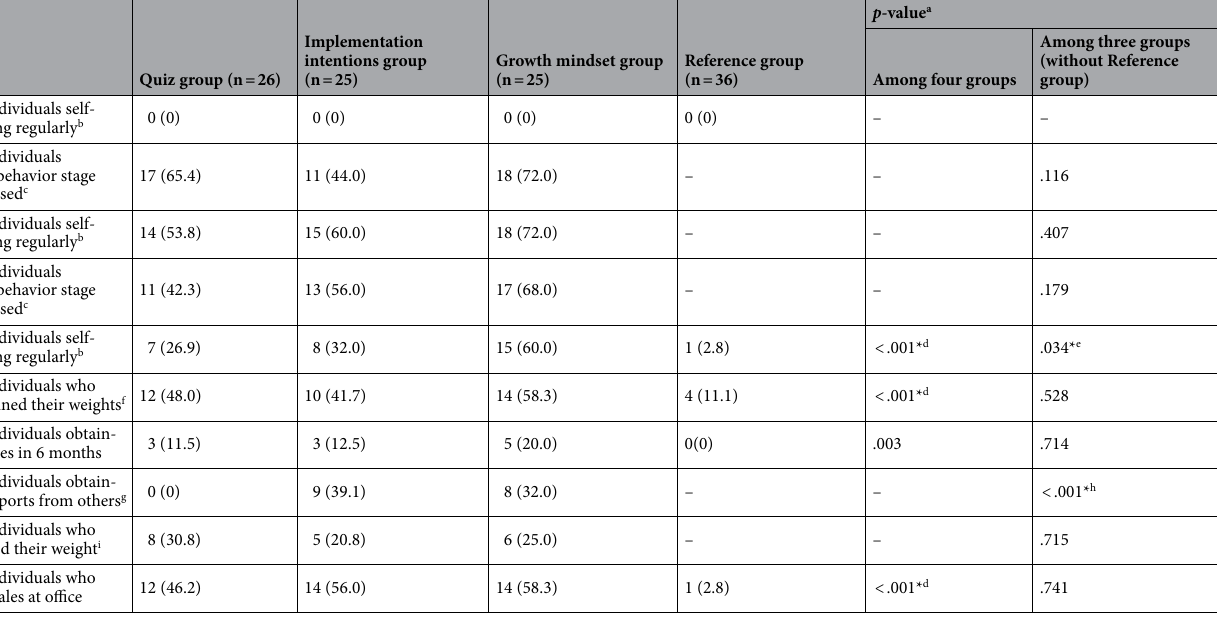
Table 2. Comparison of outcomes [n (%)]. Analysis excluding missing values, analysis of variance for continuous value data, χ 2 test, or Fisher’s exact test (items less than 5). [T0] immediately before the workshop, [T1] immediately after the workshop, [T2] 1 month after the workshop, [T3] 6 months after the workshop. a